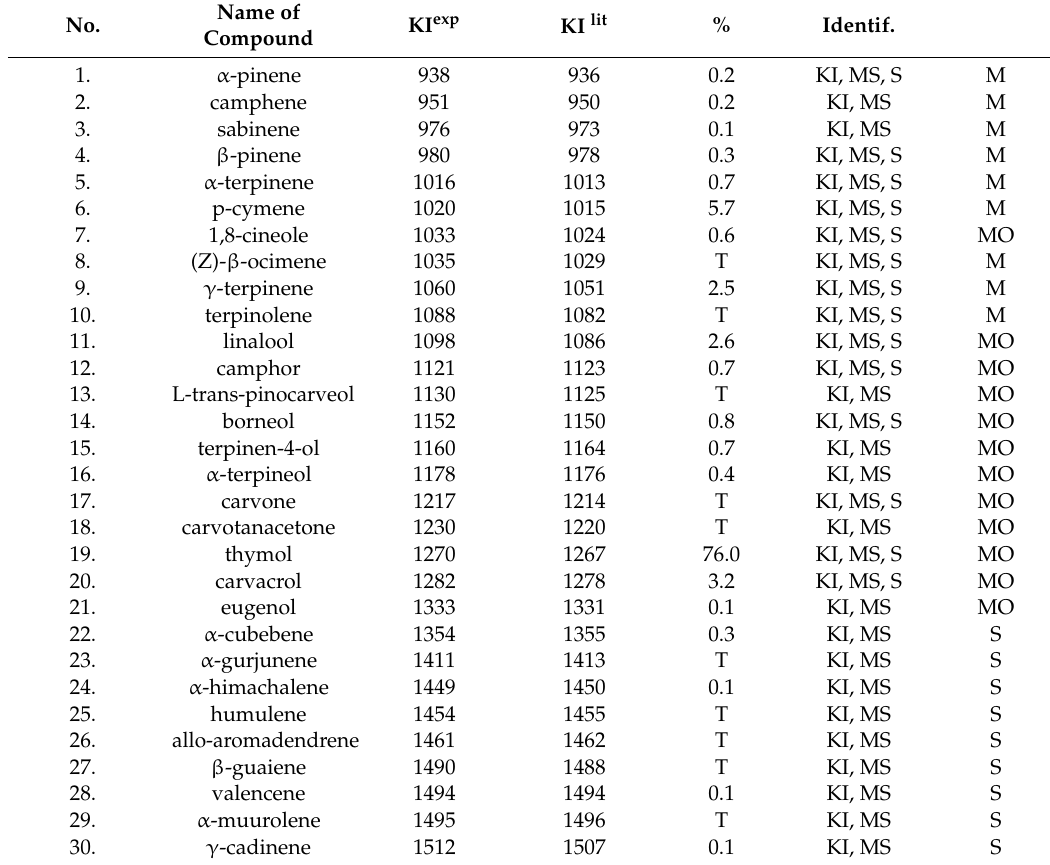
Table 1. Identified components in Origanum vulgare